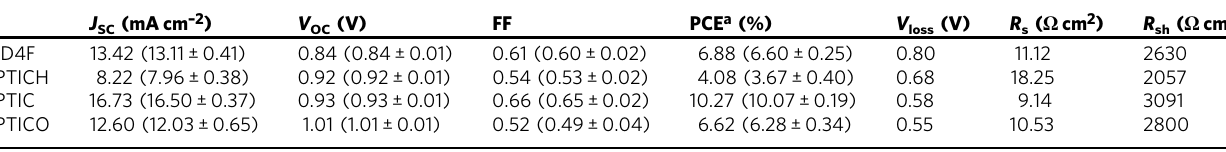
Table 2 The device parameters of OSCs with different acceptors under AM 1.5 G illumination (100 mW cm – 2 ). The resistances were extracted from the J – V curves under light